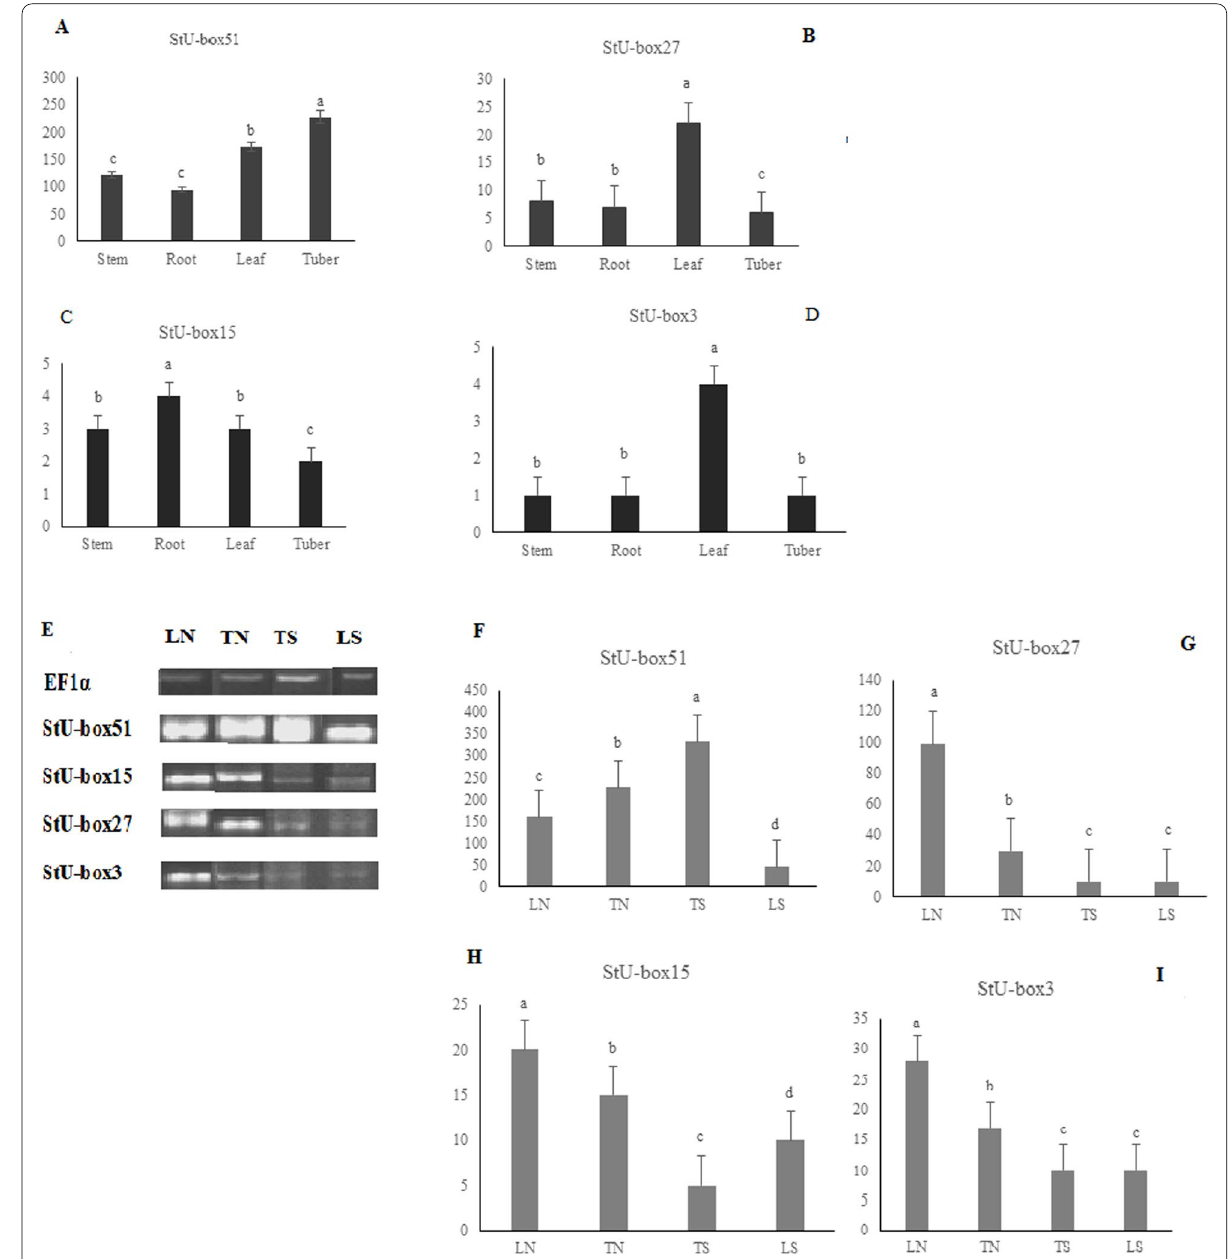
Fig. 8 The expression patterns of four candidate genes (StU-box 51, StU-box 15, StU-box 27, and StU-box 3) in four tissues (tuber, leaf, stem, and root) in S . tuberosum in A , B , C , and D in tissue-specific, respectively. Also, E RT-PCR analysis of gene expression and F – I qRT-PCR analysis of four genes in tuber and leaf under drought and normal conditions; LN (leaf normal), TN (tuber normal), TS (tuber drought stress), LS (leaf drought stress). Error bars indicate the standard errors (SE) of average